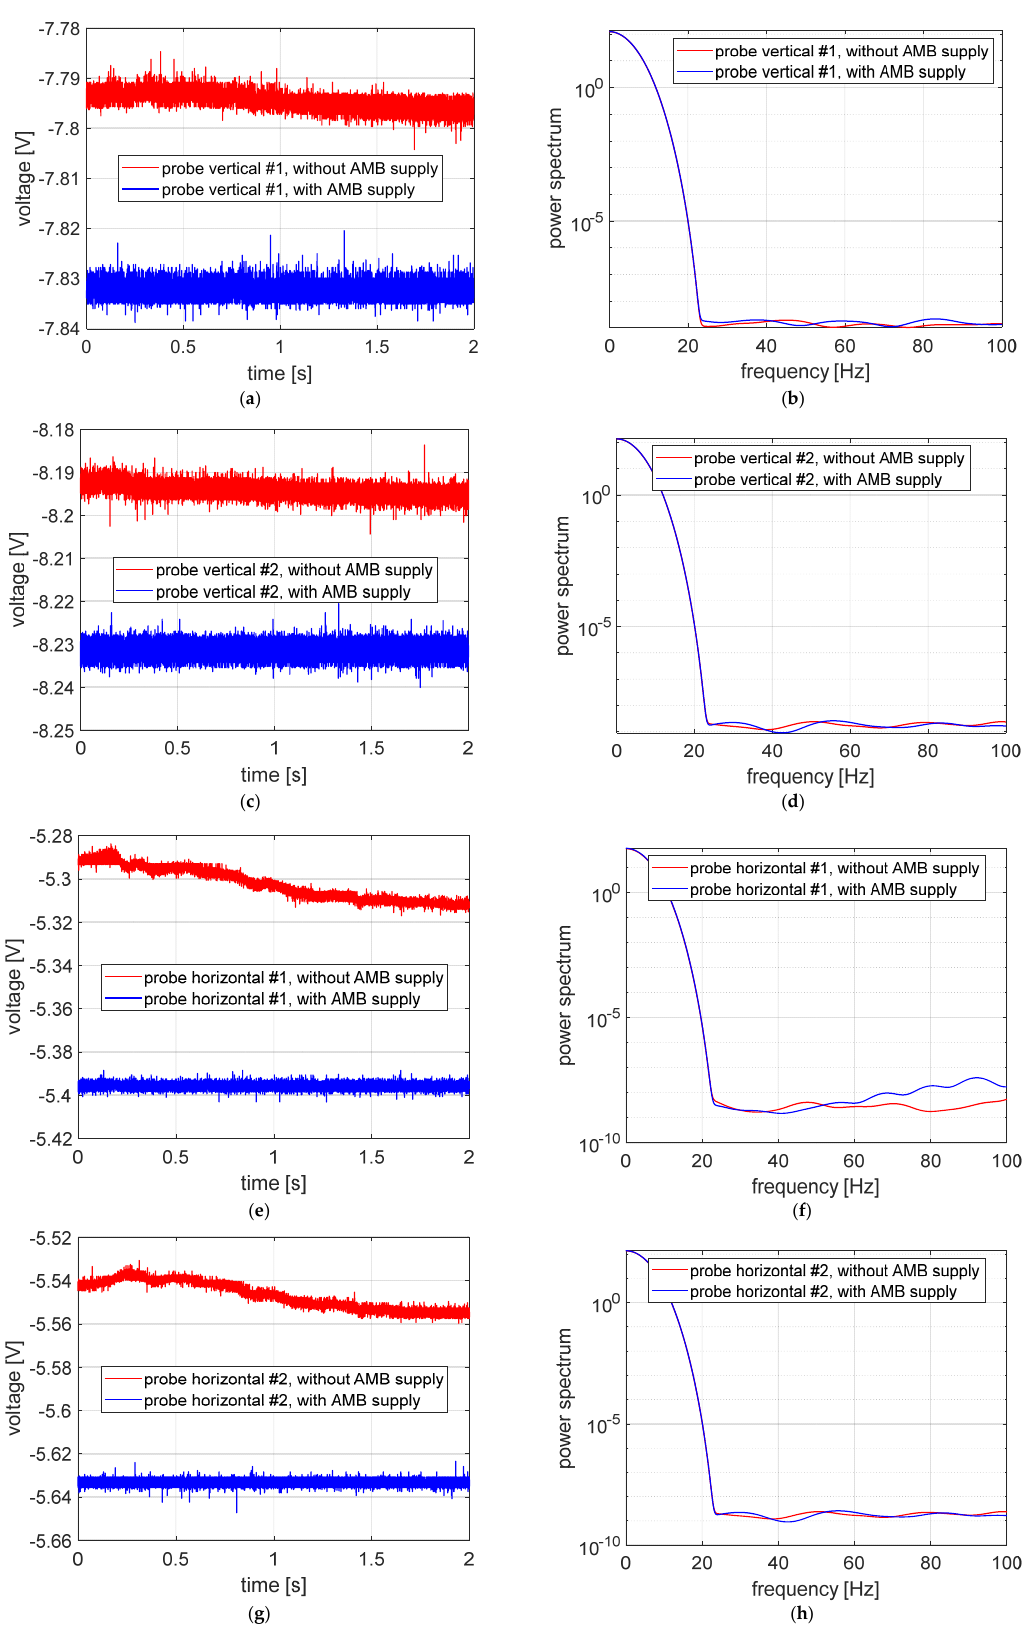
Figure 10. Measuring signals recorded during normal operation of the test stand and with the power supply of the electromagnets turned off: ( a ) time courses recorded by a vertical measuring probe #1; ( b ) power spectrum of time courses presented in ( a ); ( c ) time courses recorded by a vertical meas- uring probe #2; ( d ) power spectrum of time courses presented in ( c ); ( e ) time courses recorded by a horizontal measuring probe #1; ( f ) power spectrum of time courses presented in ( e ); ( g ) time courses recorded by a horizontal measuring probe #2; ( h ) power spectrum of time courses presented in ( g ).